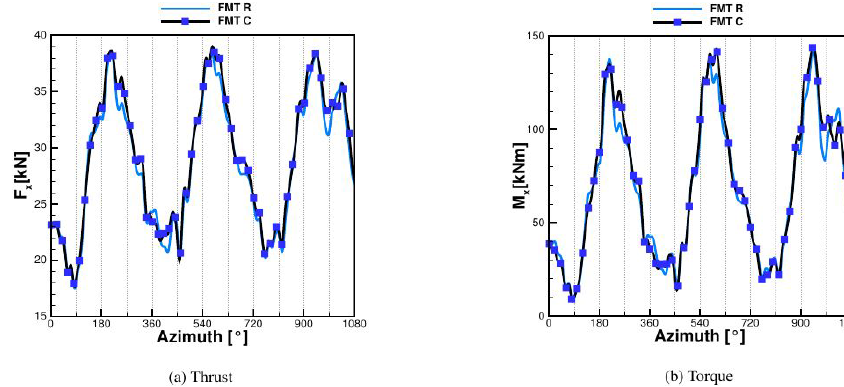
Figure 18. Global loads in FMT: comparison between rigid (R) and coupled (C) calculated with CFD.